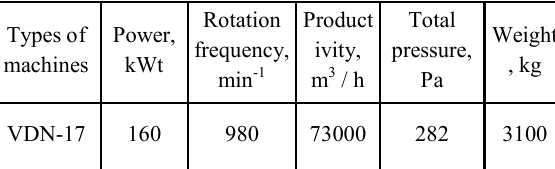
Table 1. Technical characteristics of VDN-17 draft machine